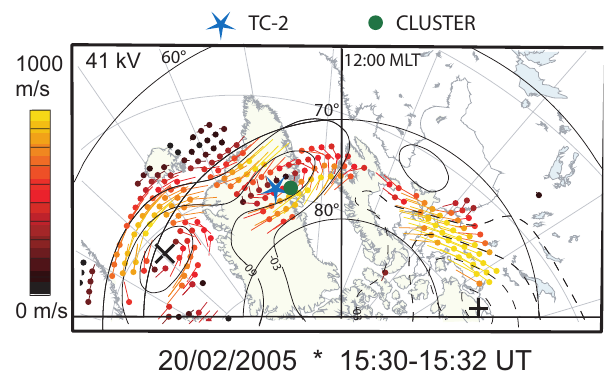
Fig. 4. SuperDARN convection map at 15:30–15:32UT in AACGM coordinates. The black solid lines represent the equipo- tential contours and the coloured dots represent the grid points where the convection vectors are determined. The green dot and the blue star represent the Cluster-1 and TC-2